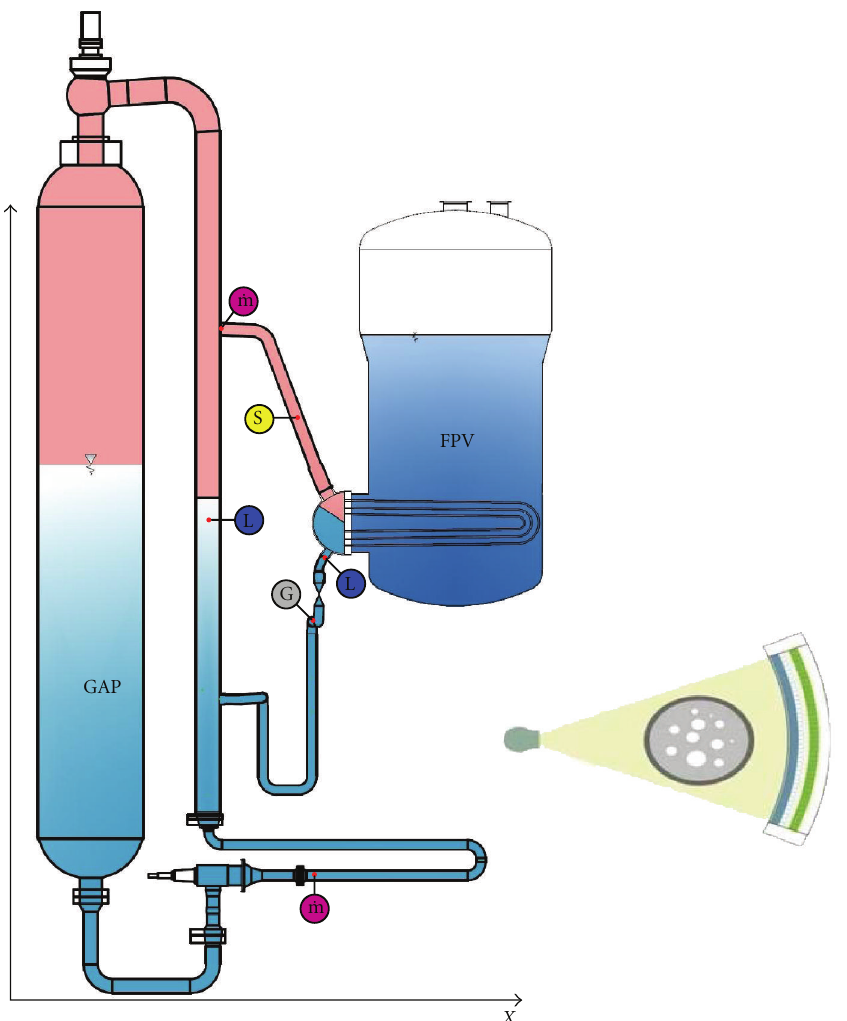
Figure 11: Instrumentation of the Emergency Condenser System